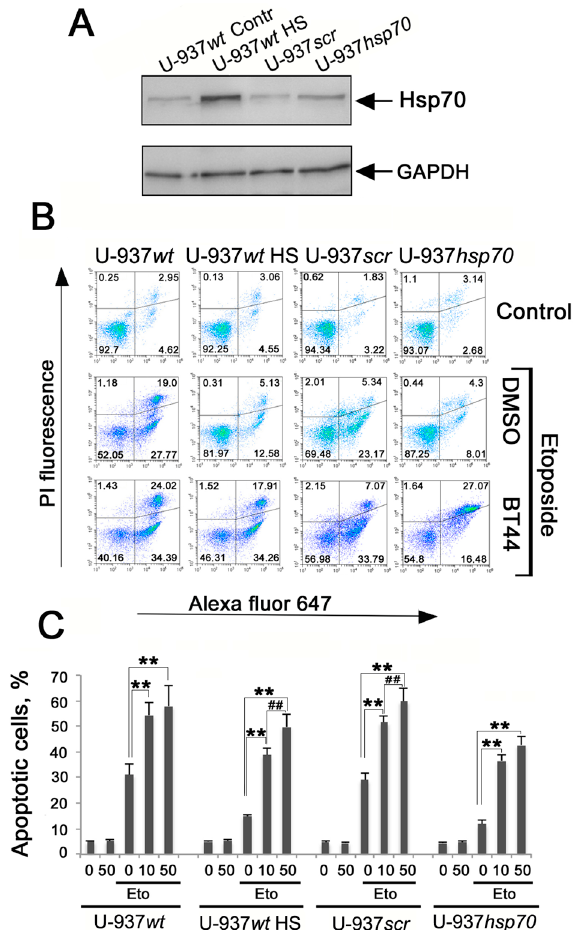
Figure 4. BT44 enhances the effect of etoposide in the induction of apoptosis in cancer cells. ( A ) Western blot of U-937 wt , U-937 scr , and U-937 hsp70 cells used for analysis. U937 wt cells were heat shocked (43 ◦ C, 30 min) and allowed to recover for 6 h (HS). The membrane was stained with the antibody against Hsp70. The representative data of two independent experiments is presented; ( B , C ) U-937 wt , control and after heat shock (U-937 wt HS), U-937 scr and U-937 hsp70 were incubated with BT44 in concentrations 10 and 50 µ M, and 2 h later 2 µ M of etoposide was added to cell culture for 18 h. Cells were stained with Annexin-V and propidium iodide (PI) and subjected to flow cytometry analysis. ( B ) Density plots of one representative experiment; ( C ) Data is presented as the means ± standard error of the mean (SEM). A statistical difference was determined by a value of ** p < 0.01; ## p < 0.01 comparing cells treated with 10 µ M and 50 µ M of BT44 and etoposide; the data of five independent experiments is summarized.